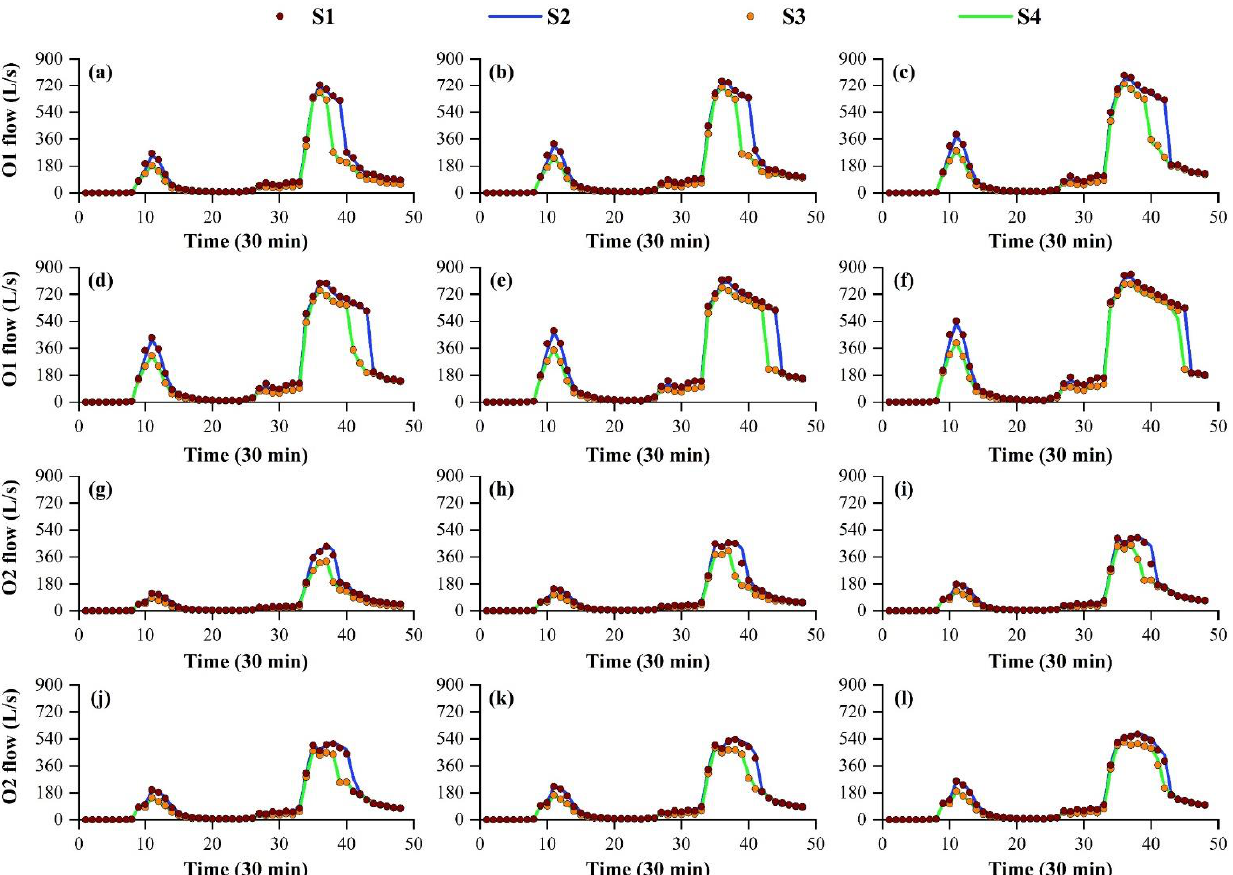
Figure 3. Flow hydrographs at outfalls (O1 and O2) for the various scenarios (S1, S2, S3, and S4) and rainfall events with return periods of: ( a , g ) 5; ( b , h ) 10; ( c , i ) 20; ( d , j ) 30; ( e , k ) 50; and ( f , l ) 100